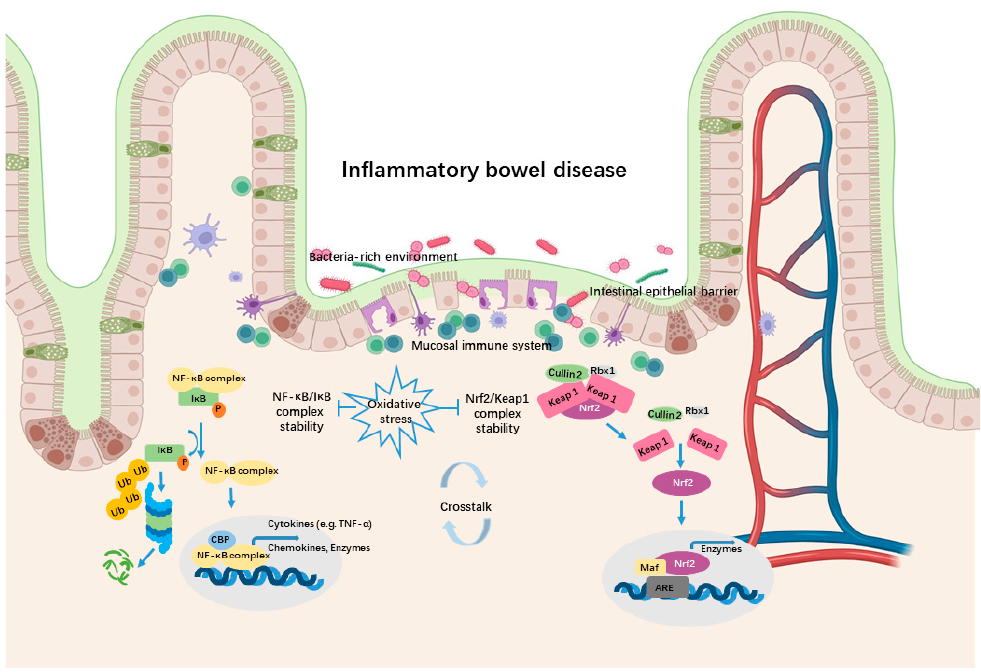
Figure 2. Schematic representation of the inflammatory response of antioxidant pathways in the intestinal environment. In the immune cells, oxidation stress can enhance the dissociation of the NF- κ B/I κ B complex and the Nrf2/Keap1 complex, which cause the induction of pro-inflammation genes (e.g., cytokines, chemokines) and antioxidant genes (e.g., enzymes). The crosstalk between these two pathways through a complex molecular interaction plays an important role in IBD. NF- κ B—nuclear factor-kappaB; Ub—ubiquitination; CBP—CREB-binding protein; Nrf2—NF-E2p45-related factor 2; Keap1—Kelch-like ECH-associated protein 1; ARE—antioxidant responsive element. Created by